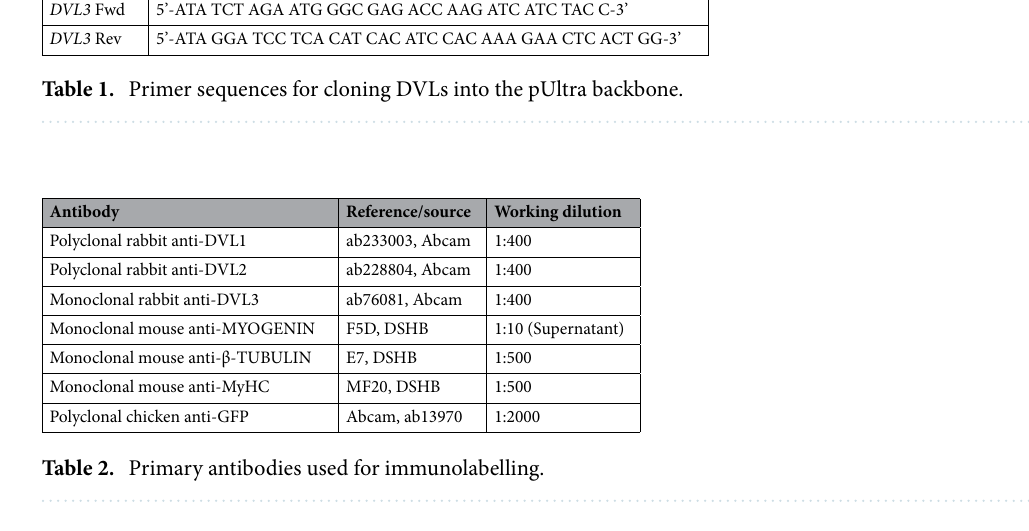
Protein and subcellular fractioning were performed according to the ABCAM protocol. In brief: plated cells were washed with ice cold PBS, scraped, lysed in fractioning buffer (20 mM HEPES, 10 mM KCl, 2 mM MgCl 2 , 1 mM EDTA, 1 mM EGTA and freshly added 1 mM DTT and PI Cocktail III 1:200) and incubated on ice for 15 min. Samples were passed through a 27G needle until cells were lysed and incubated on ice for 20 min. Samples were centrifuged at 720 g for 5 min and the supernatant containing the cytoplasm fraction collected. The nuclear pellet was washed in 500 µl fractioning buffer, passed through a 23G needle 10 times and centrifuged for 10 min at 720 g. The supernatant (containing the nuclear